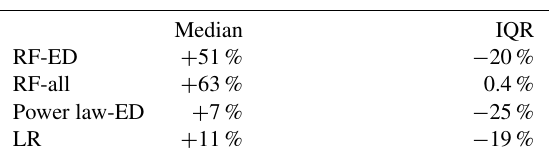
Table 5. Relative change (%) in TS distribution between sample sizes of 900 and